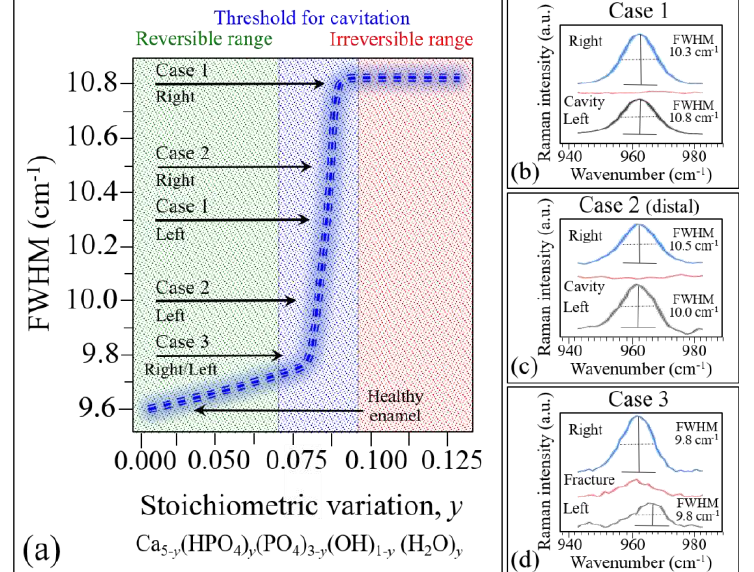
Figure 11. ( a ) Relationship between the FWHM of the 960 cm −1 Raman band of hydroxyapatite and the stoichiometry parameter y from Ref. [7] (cf. Figure 11b and related text in that reference); and the average Raman spectra from three different areas (cf. labels) of the tooth samples in Cases 1 ( b ), 2 ( c ), and 3 ( d ); the FWHM of average bands are analyzed in ( a ). The terms “right” and “left” in ( b ) refer to the distal and mesial sides of the cavity, respectively, inside the cavitated area encircled in inset to Figure 8c. Similarly, the same terms in ( c ) and ( d ) refer to buccal and lingual sides of the cavity, respectively, with reference to the cavitated areas encircled in Figures 9c and 10c, respectively.